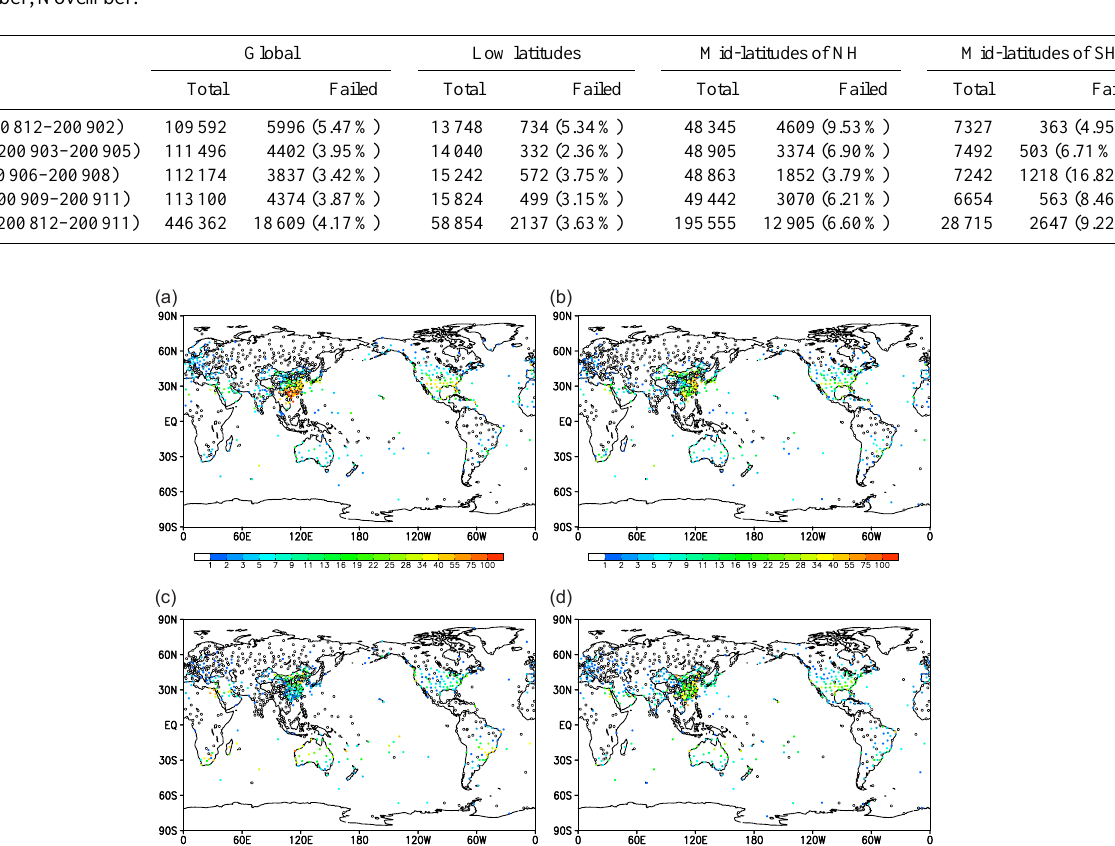
Table 1. Statistics of total and failed relative humidity observations from December 2008 to November 2009 for global observations